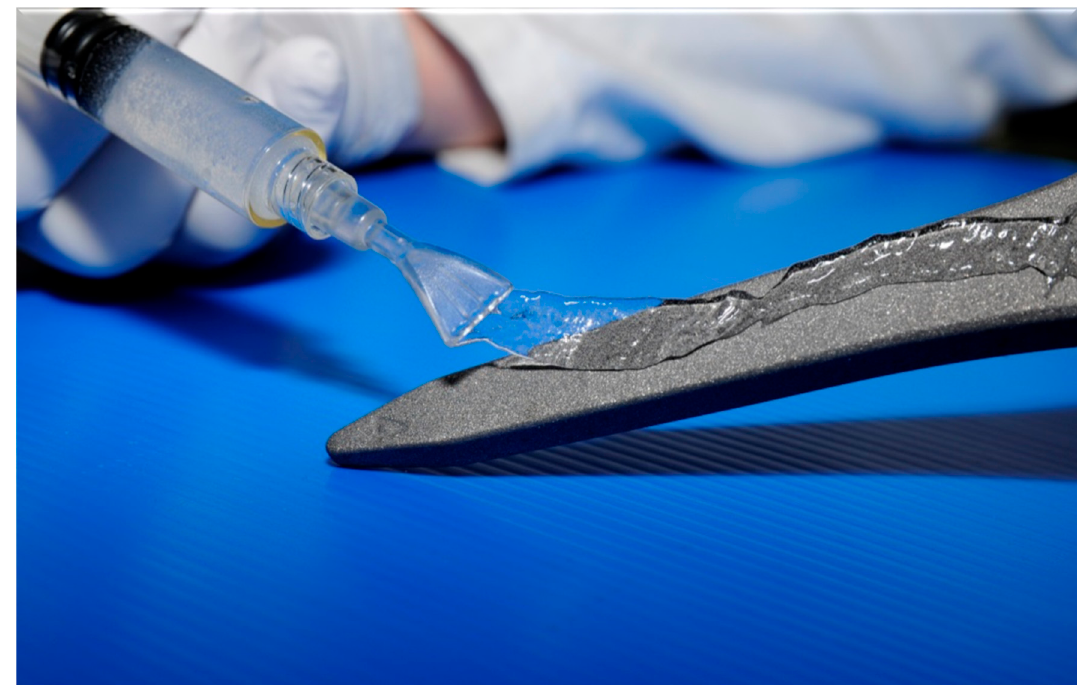
Figure 6. Defensive anti-bacterial coating (DAC; Novagenit, Trento, Italy)—a bioabsorbable, antibiotic-containing hydrogel which is designed to slow or prevent bacterial adhesion and biofilm formation.